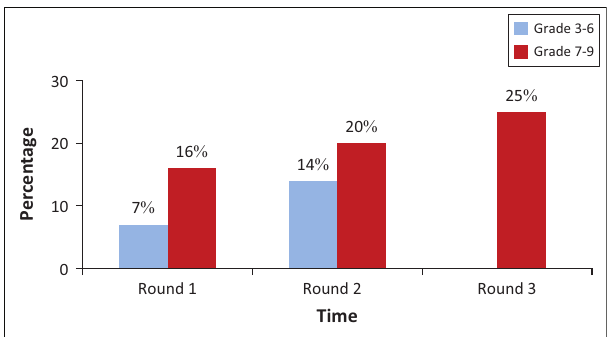
FIGURE 2: Time spent engaging with errors in classroom